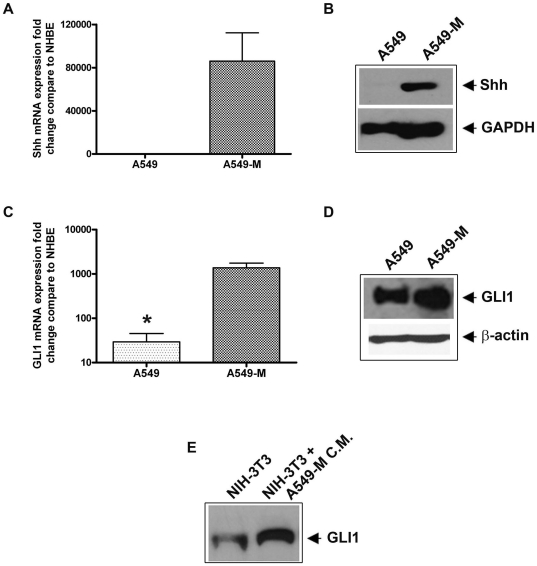
A549-M cells showed up-regulation of sonic hedgehog (Shh) and GLI expression both at the mRNA and protein levels:A and B showing qRT-PCR and Western blot results, respectively for the expression of Shh whereas C and D represent the expression status of GLI at the mRNA and protein levels, respectively in A549-M cells compared to parental A549 cells. E represent Western blot data of GLI1 expression in NIH-3T3 cell after culturing with A549-M-derived conditioned media showing higher levels of GLI1 expression. (*  =  p<0.05).